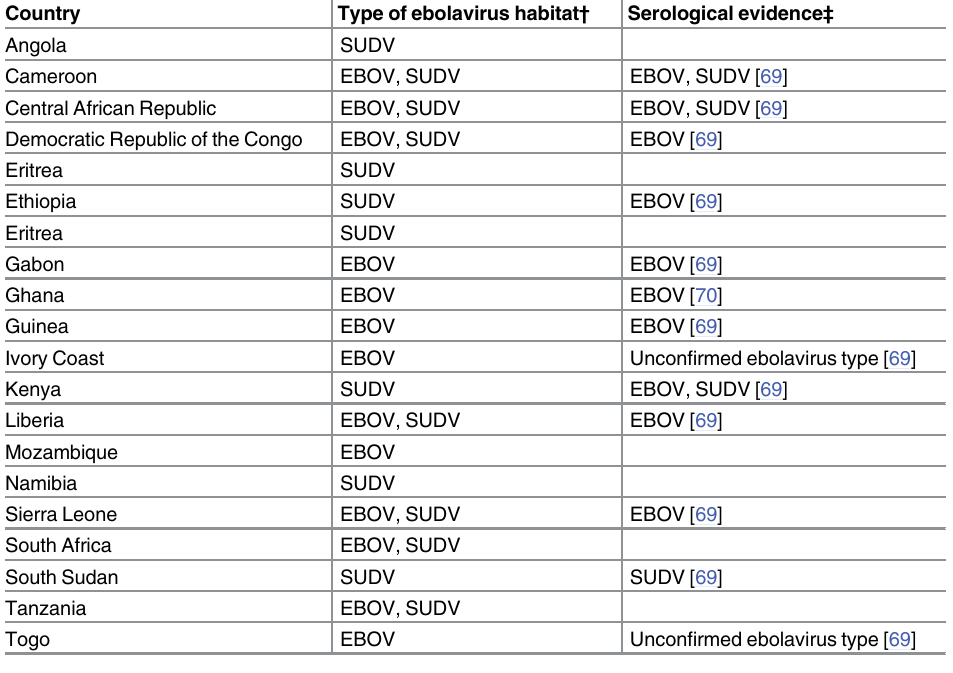
Table 3. African countries with suitable habitat for ebolavirus spillover and serological evidence.